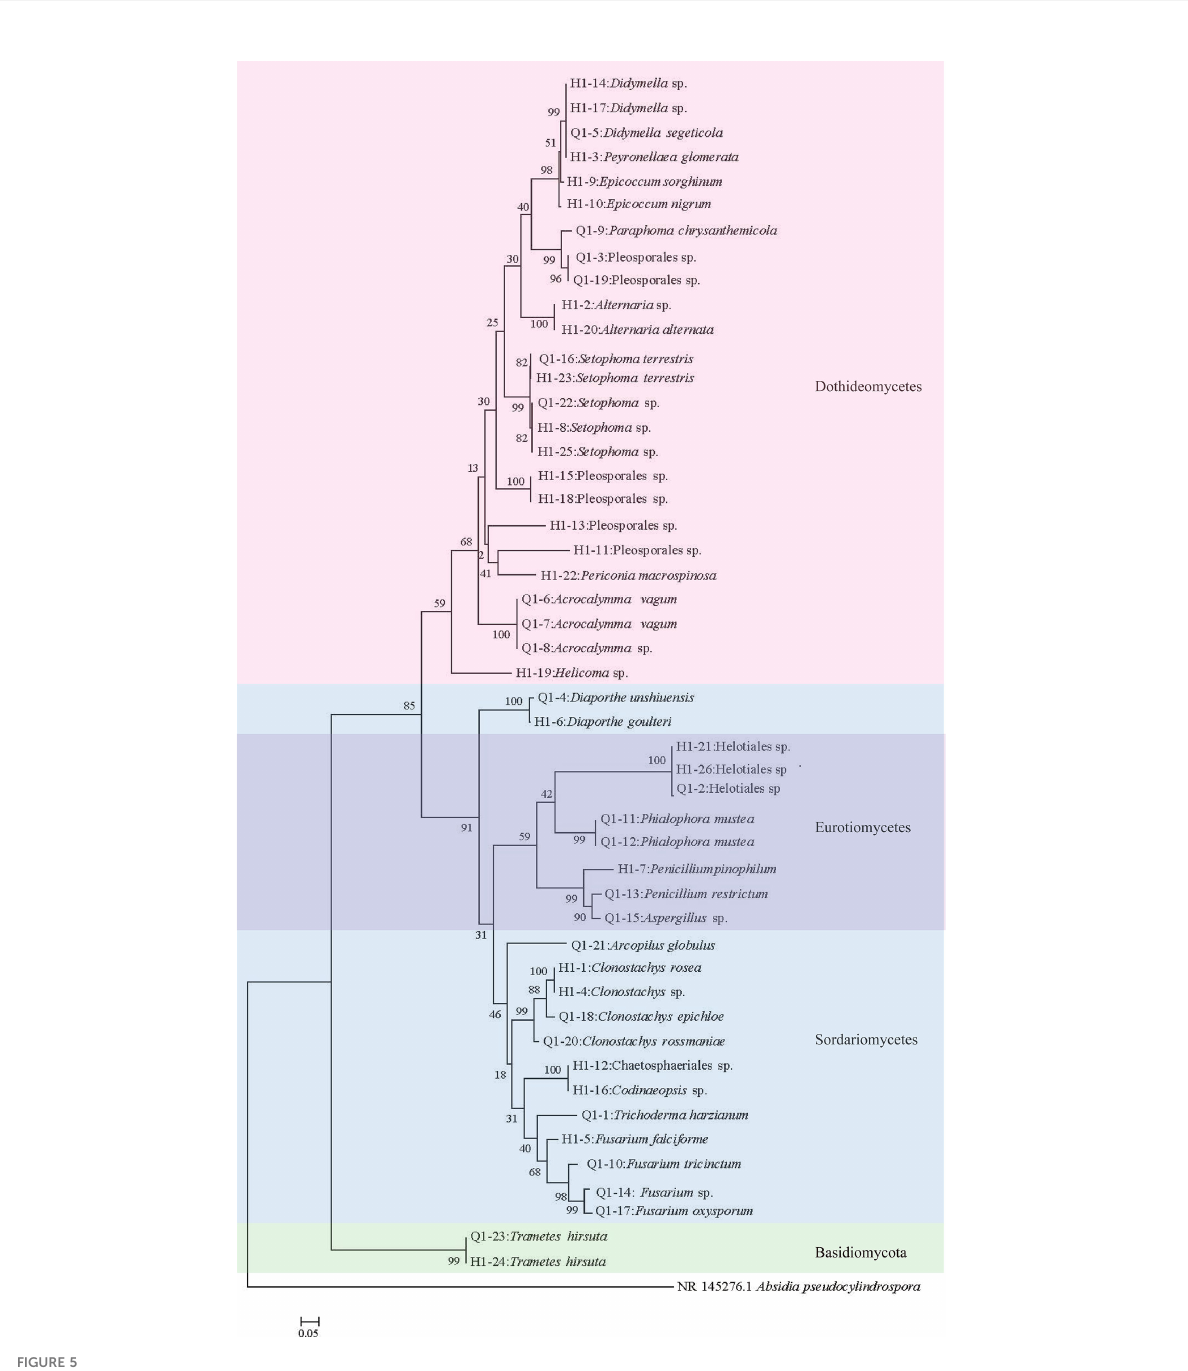
FIGURE 5 Phylogenetic tree of endophytic fungi in Qianhu. Each color corresponds to a